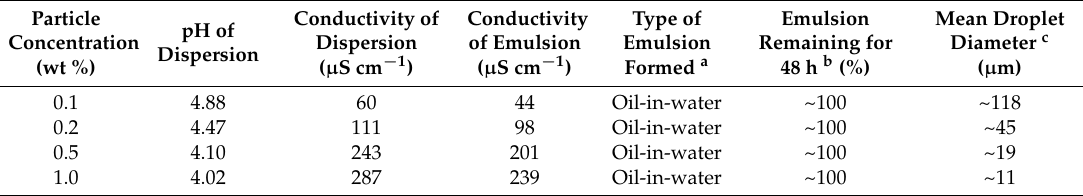
Table 2. Properties of the Pickering emulsions of n -hexadecane stabilized by PMDA-ODA particles with different concentrations (oil-water volume ratio =